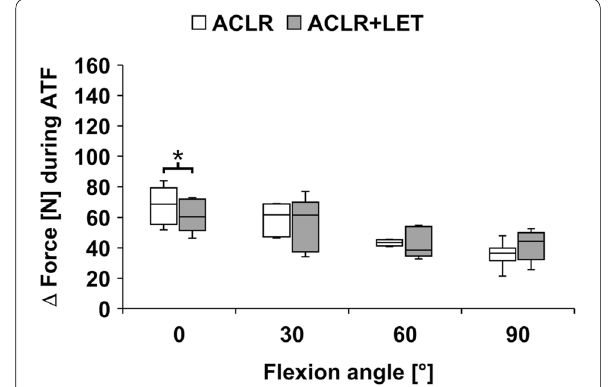
Fig. 3 Graft forces in the anterior cruciate ligament reconstruction (ACLR) during the application of anterior tibial translation force (ATF) for the isolated ACLR and the ACLR with addition of a lateral extra-articular tenodesis (ACLR LET). The forces indicated in + the graph are relative to the unloaded state (Δ force). Significant differences between the two procedures are marked with an